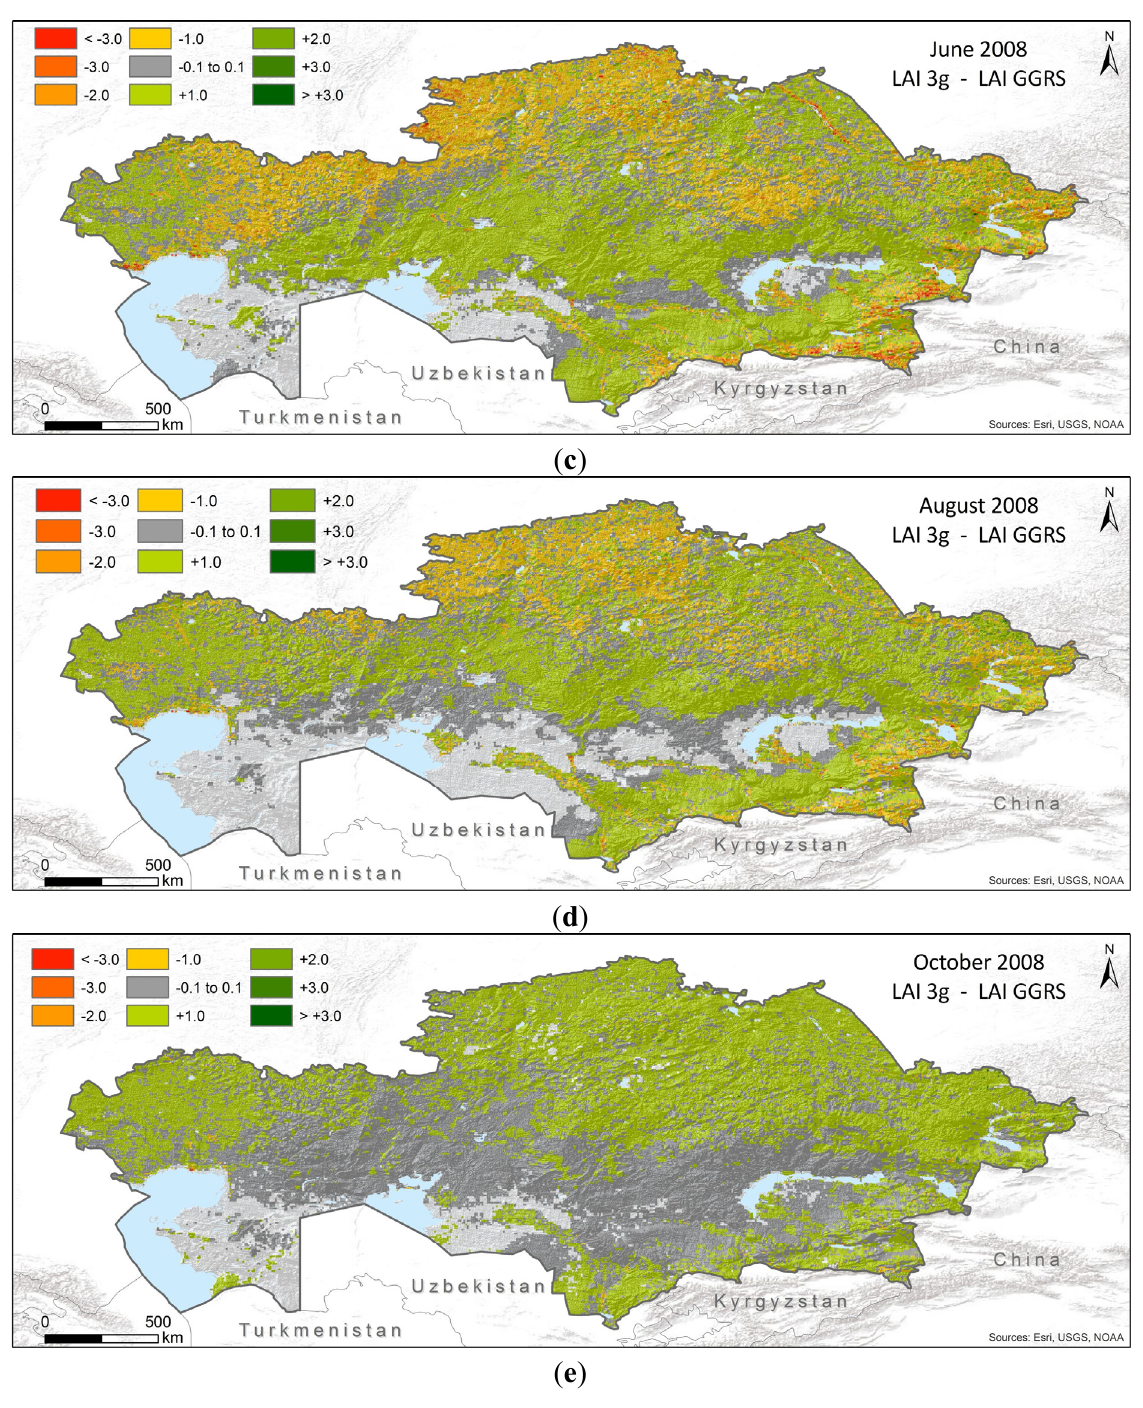
Figure 8. Differences (LAI3g minus LAI GGRS) between the compared LAI products for specific months in 2008: ( a ) January; ( b ) April; ( c ) June; ( d ) August; and ( e )